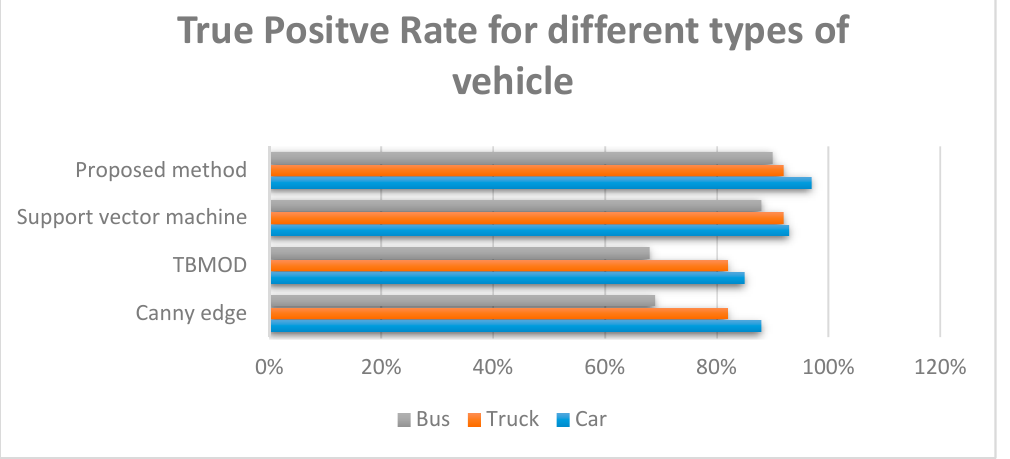
Figure 19. Success rate for various types of vehicle (true-positive rate) and comparison with other methods: Support vector machine [15], TBMOD [8] and Canny edge [7].